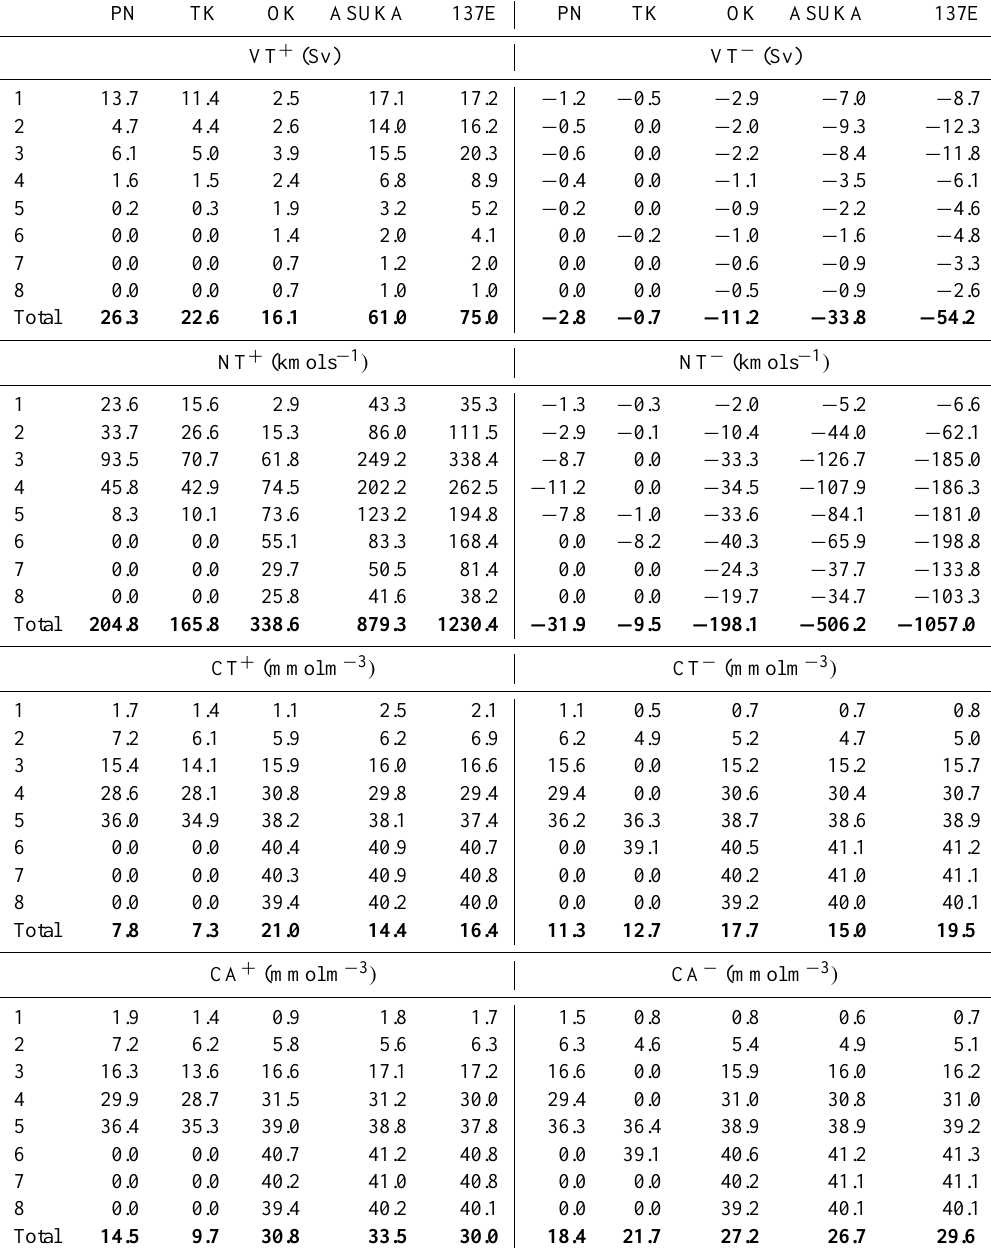
Table 1. Along-stream variation of positive volume transport VT + (Sv) and negative volume transport VT − (Sv), positive nutrient transport NT + (kmols − 1 ) and negative nutrient transport NT − (kmols − 1 ) , positive transport-averaged nitrate concentration CT + (mmolm − 3 ) and negative transport-averaged nitrate concentration CT − (mmolm − 3 ) , area-averaged nitrate concentrations for area with positive volume transport CA + (mmolm − 3 ) and negative volume transport CA − (mmolm − 3 ) , net volume transport VT = VT + + VT − (Sv) and net